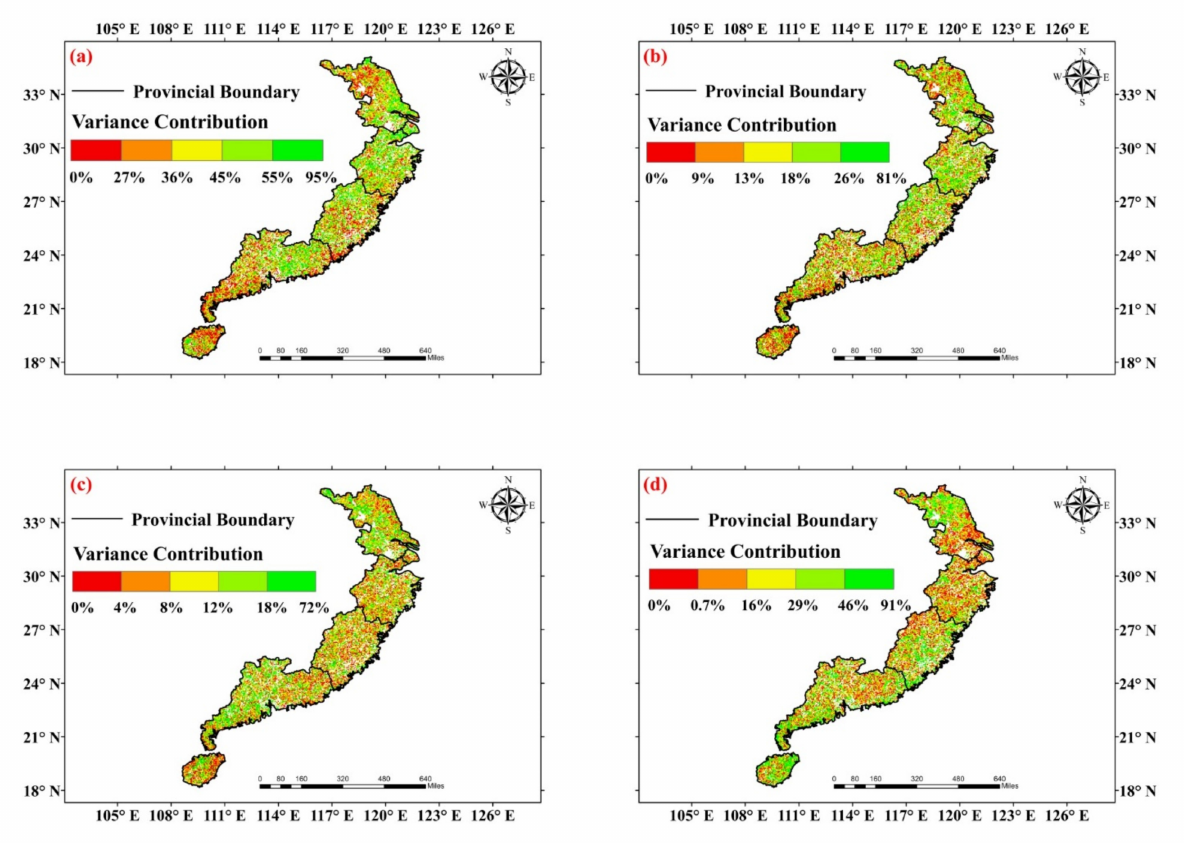
Figure 7. Spatial distribution of the variance contribution rates of different time scales to NPP changes, classified using 20% quantiles: ( a ) 3-year time scale, ( b ) 6-year time scale, ( c ) 15-year time scale, and ( d ) long-term